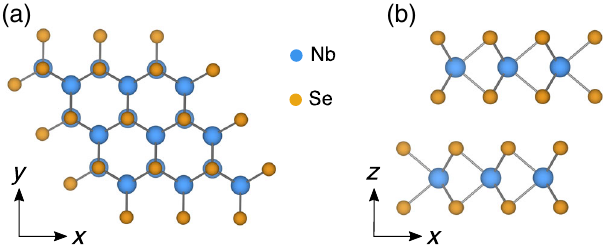
FIG. 1. (a) Crystal structure of bulk NbSe 2 illustrating the (a) top view and (b) side view of the structure. The x , y , and z axes denote the Cartesian axes.